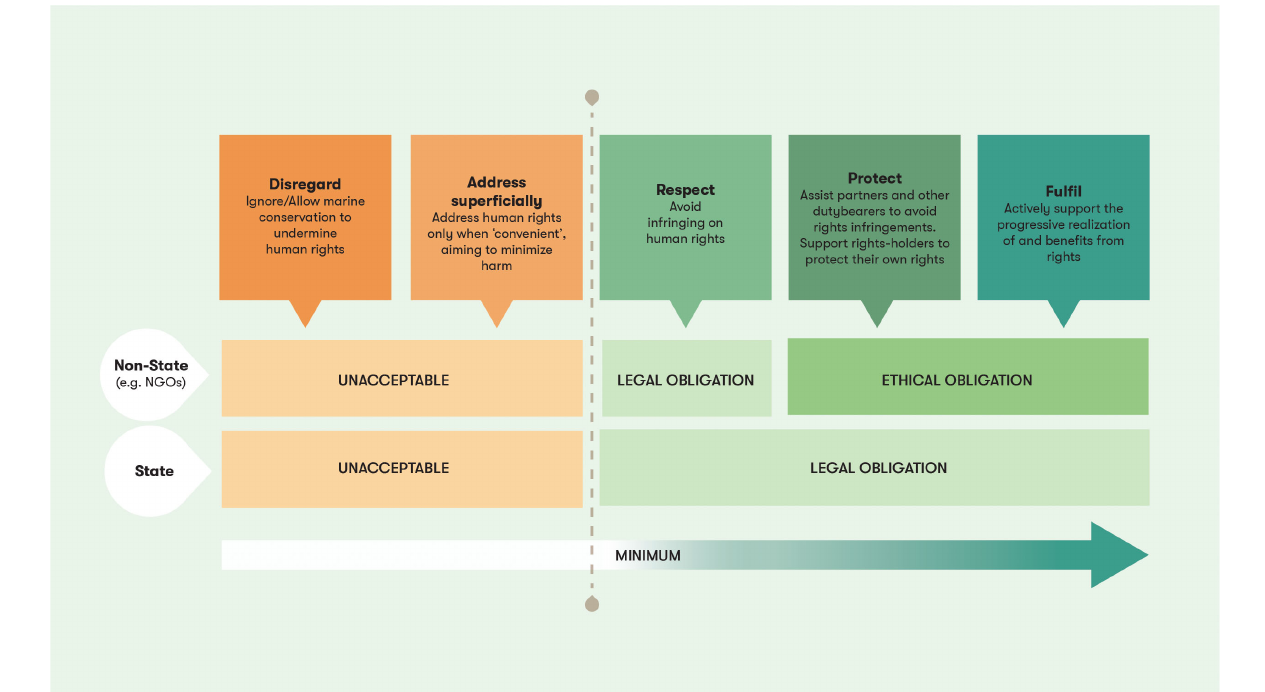
Smallhorn-West et